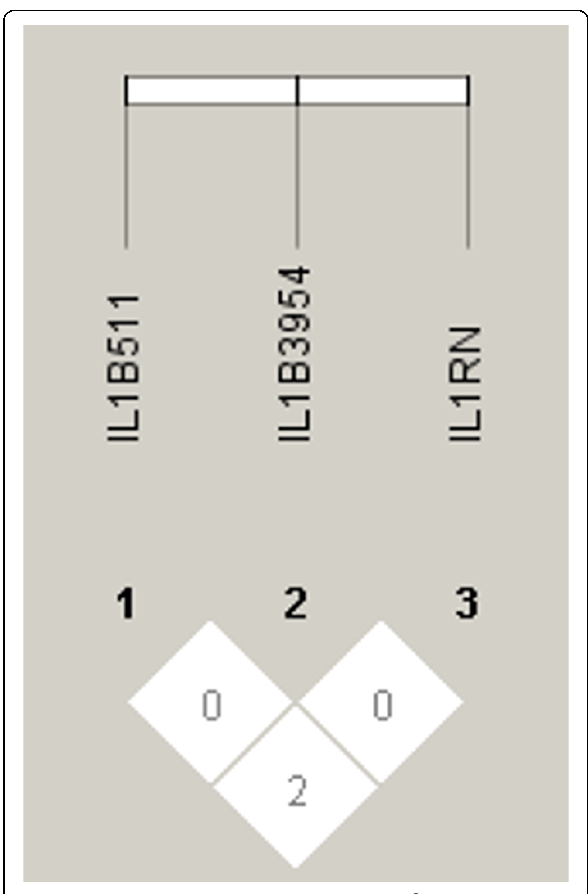
Figure 2 Linkage disequilibrium plots (r 2 ) are shown for non- athletes